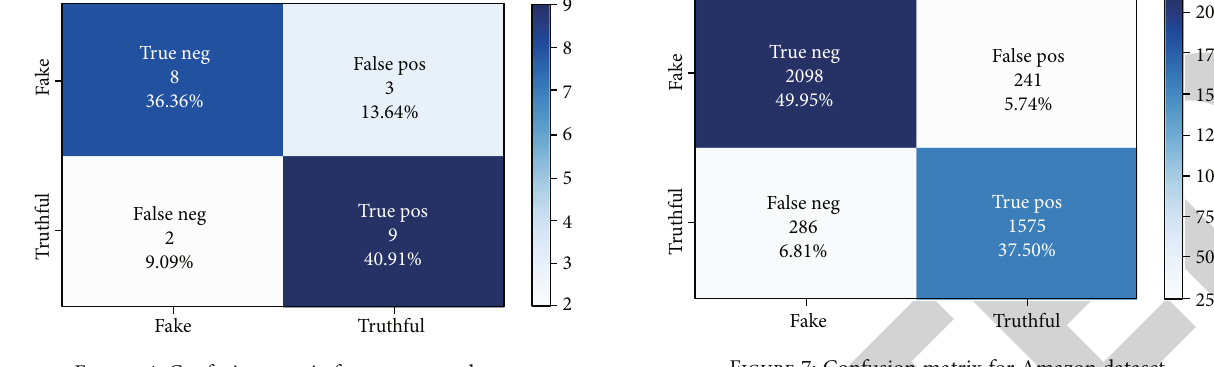
Figure 4: Confusion matrix for restaurant dataset.